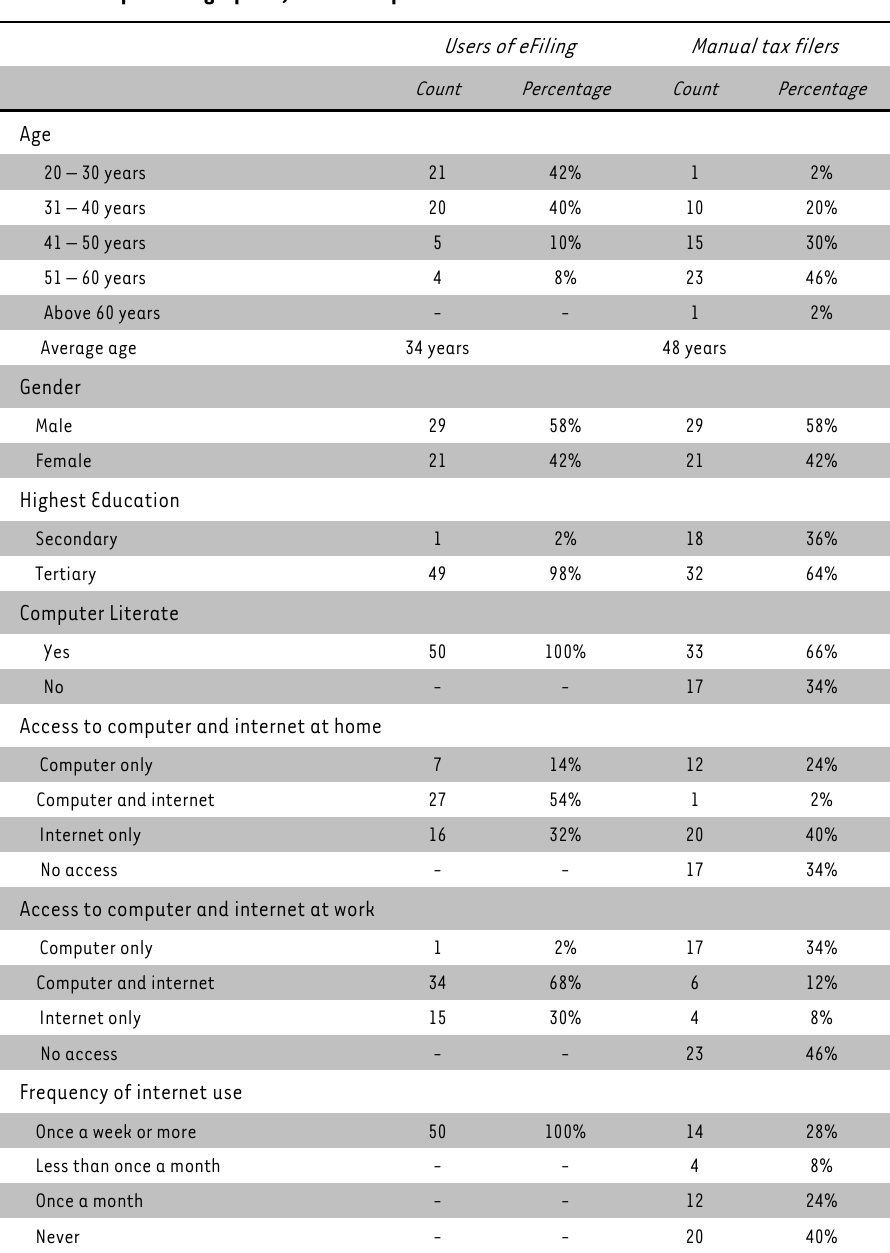
TABLE 1: Sample demographics, education profile and access to resources Users of eFiling Manual tax